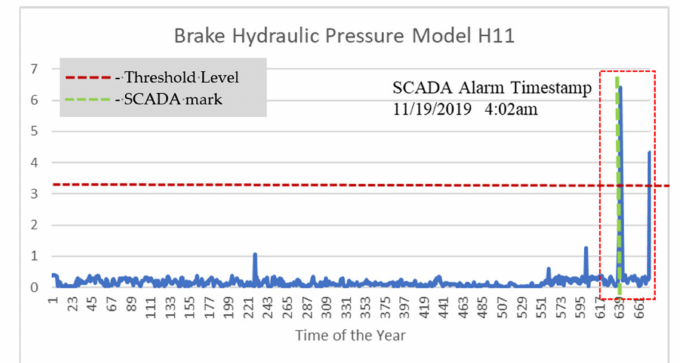
Figure 4. Mahalanobis distance based on the brake hydraulic pressure model for H11.